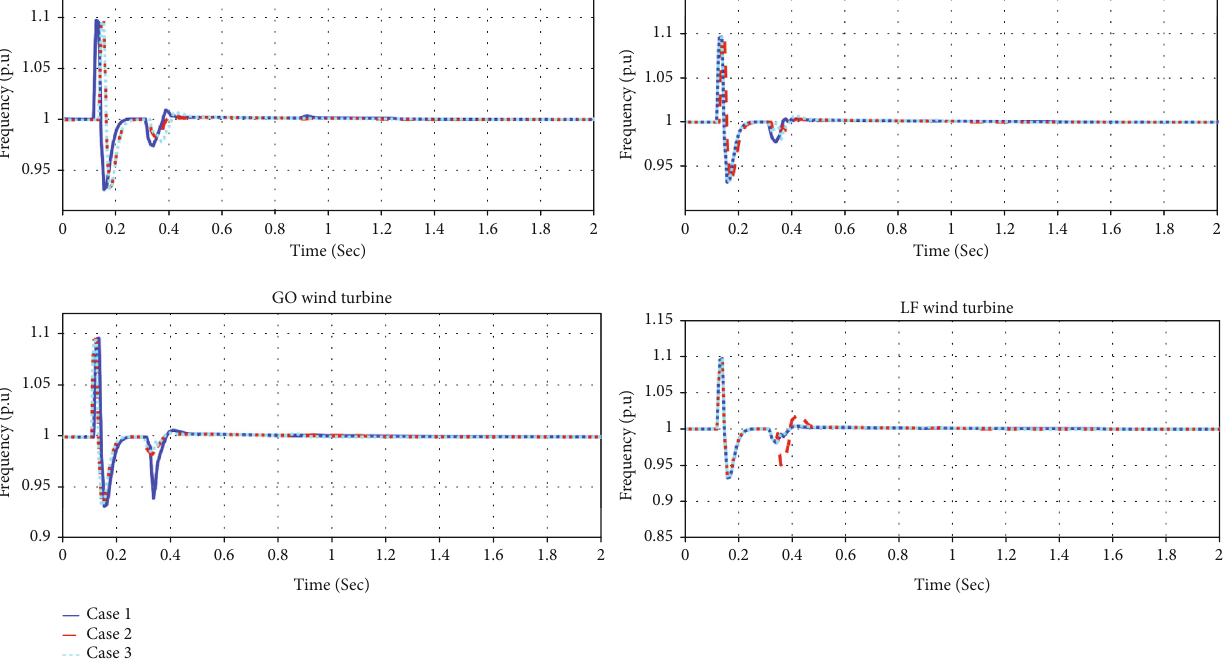
Figure 9: Frequency responses for wind turbine modules according to the four dispatch strategies. This fi gure is reproduced from Shezan et al.